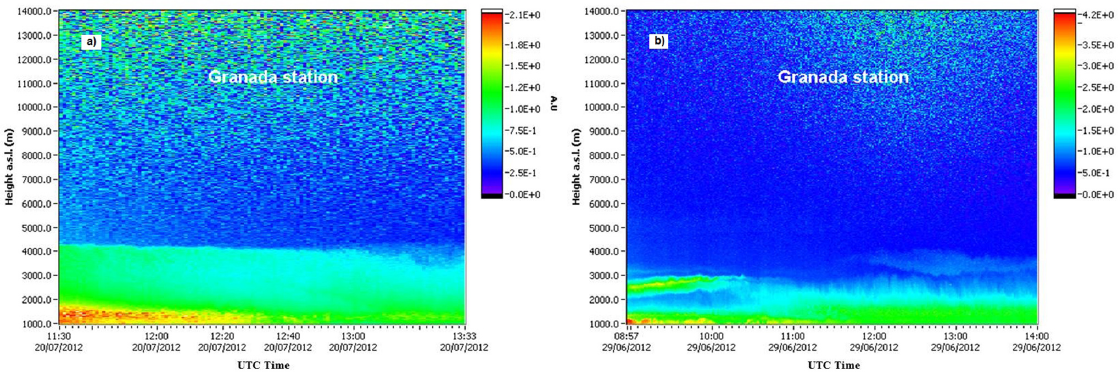
Figure 8. Lidar vertical profiles obtained for (a) 29 June from 08:57 to 14:00UTC and (b) 20 July 11:30 to 13:30UTC.